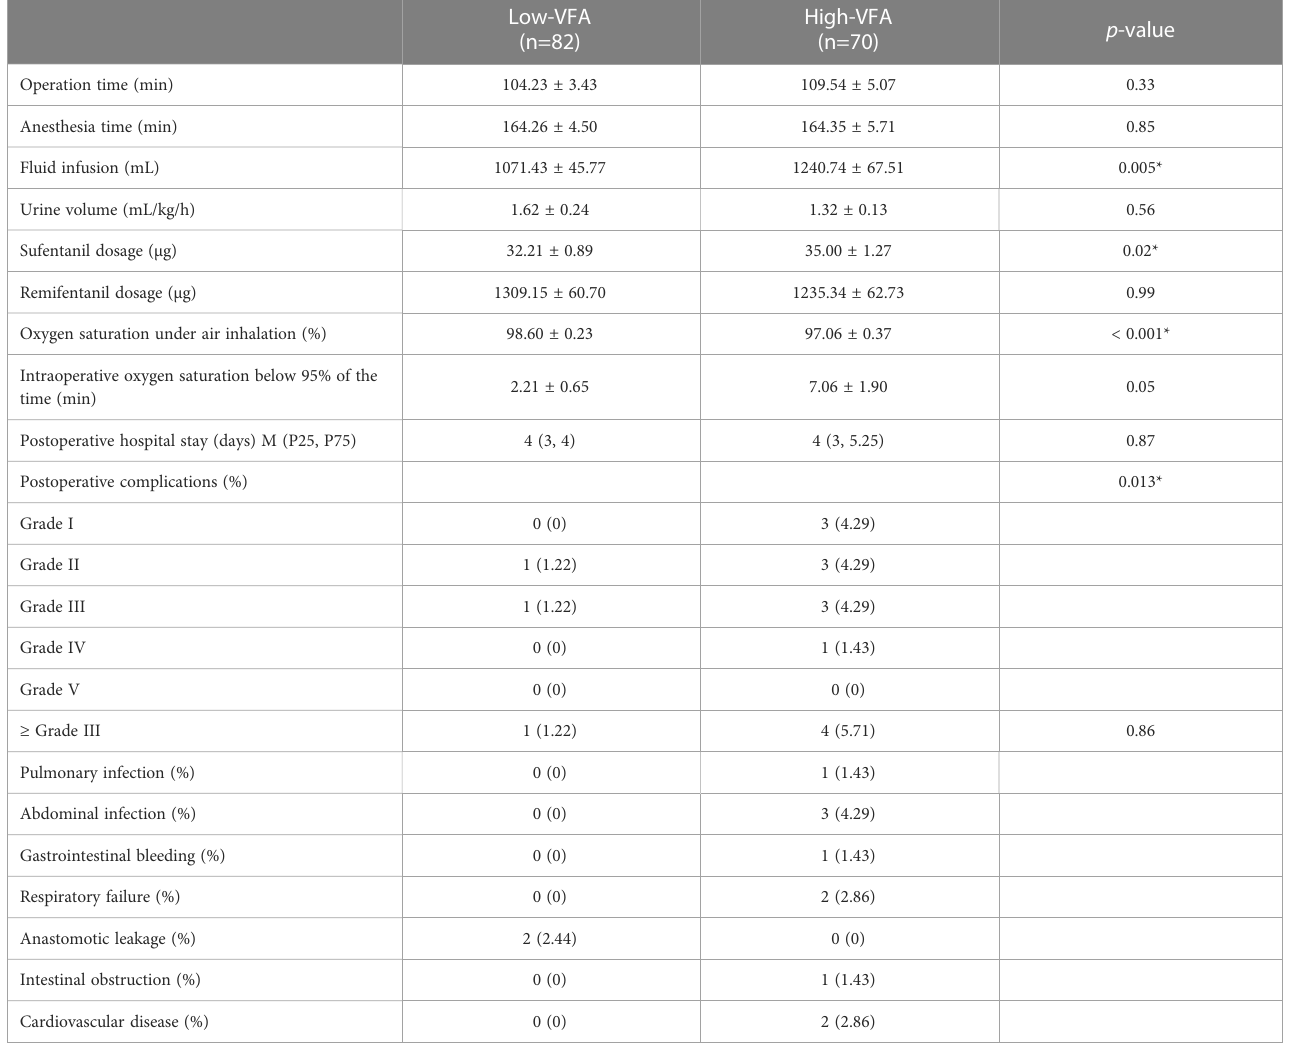
TABLE 2 Perioperative management and outcomes of low-VFA vs. high-VFA